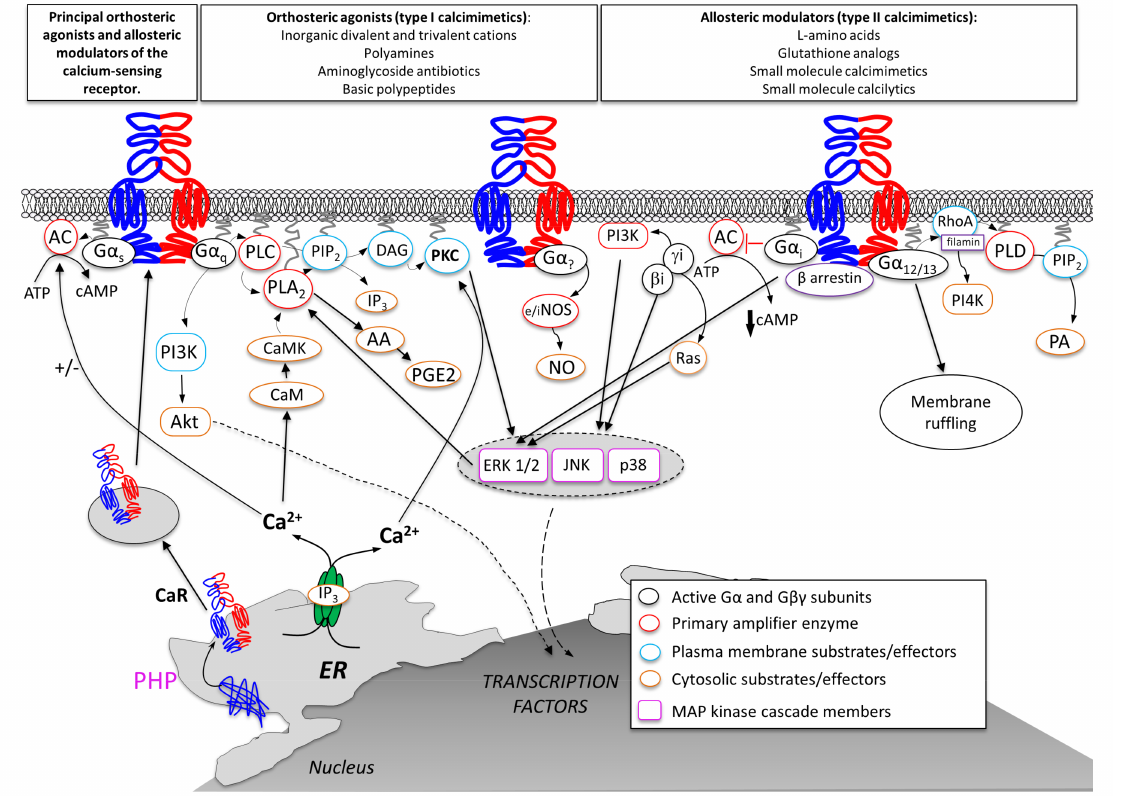
Figure 2. Schematic illustration of intracellular transduction cascades activated by orthosteric agonists or allosteric modulators on the CaR. Modified from